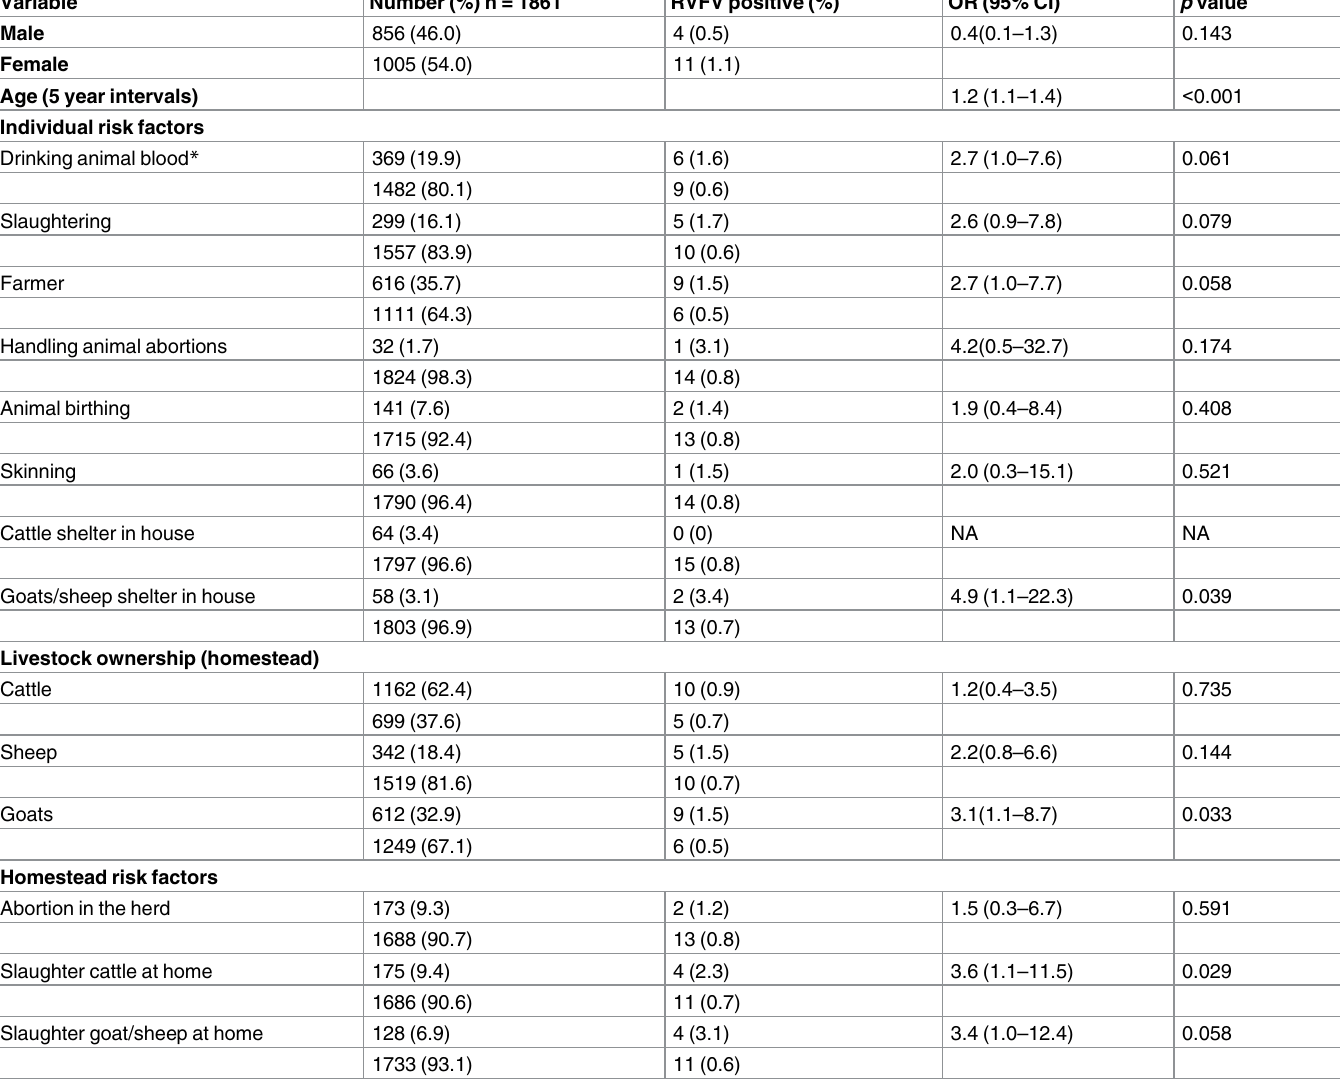
Table 1. Results of univariable analysis for risk factors for RVFV seropositivity in community